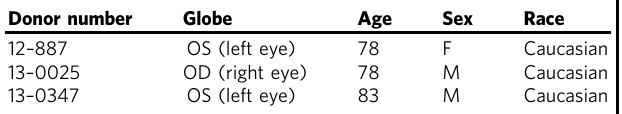
Table 1 Medical information of the sample